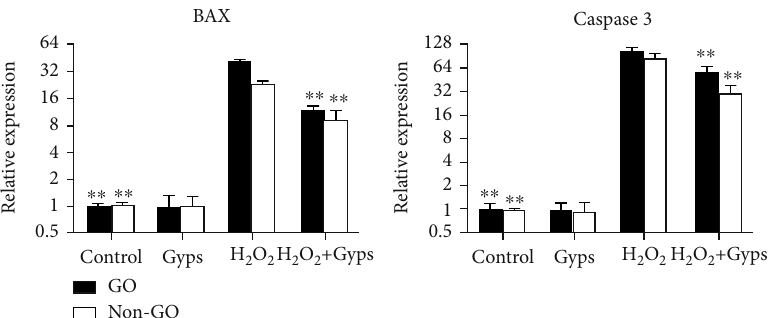
Figure 6: E ff ect of gypenosides on the production of apoptosis-related protein and autophagy-related protein mRNA in orbital fi broblasts of patients with GO. Intervention was carried out according to di ff erent groups. The extracted RNA was reverse transcribed by real-time fl uorescence quantitative PCR. Preintervention of gypenosides could signi fi cantly inhibit the mRNA expression of caspase-3 and BAX in orbital fi broblasts of GO and non-GO patients. Three samples from each of the three GO and non-GO donors were taken for the experiment. All detections are repeated 3 times, with 3 replicate wells each time ( ∗ as P < 0 : 05 and ∗∗ as P < 0 : 01 ; P < 0 : 05 means the di ff erence is statistically signi fi cant, and P value is analyzed by two-way ANOVA).